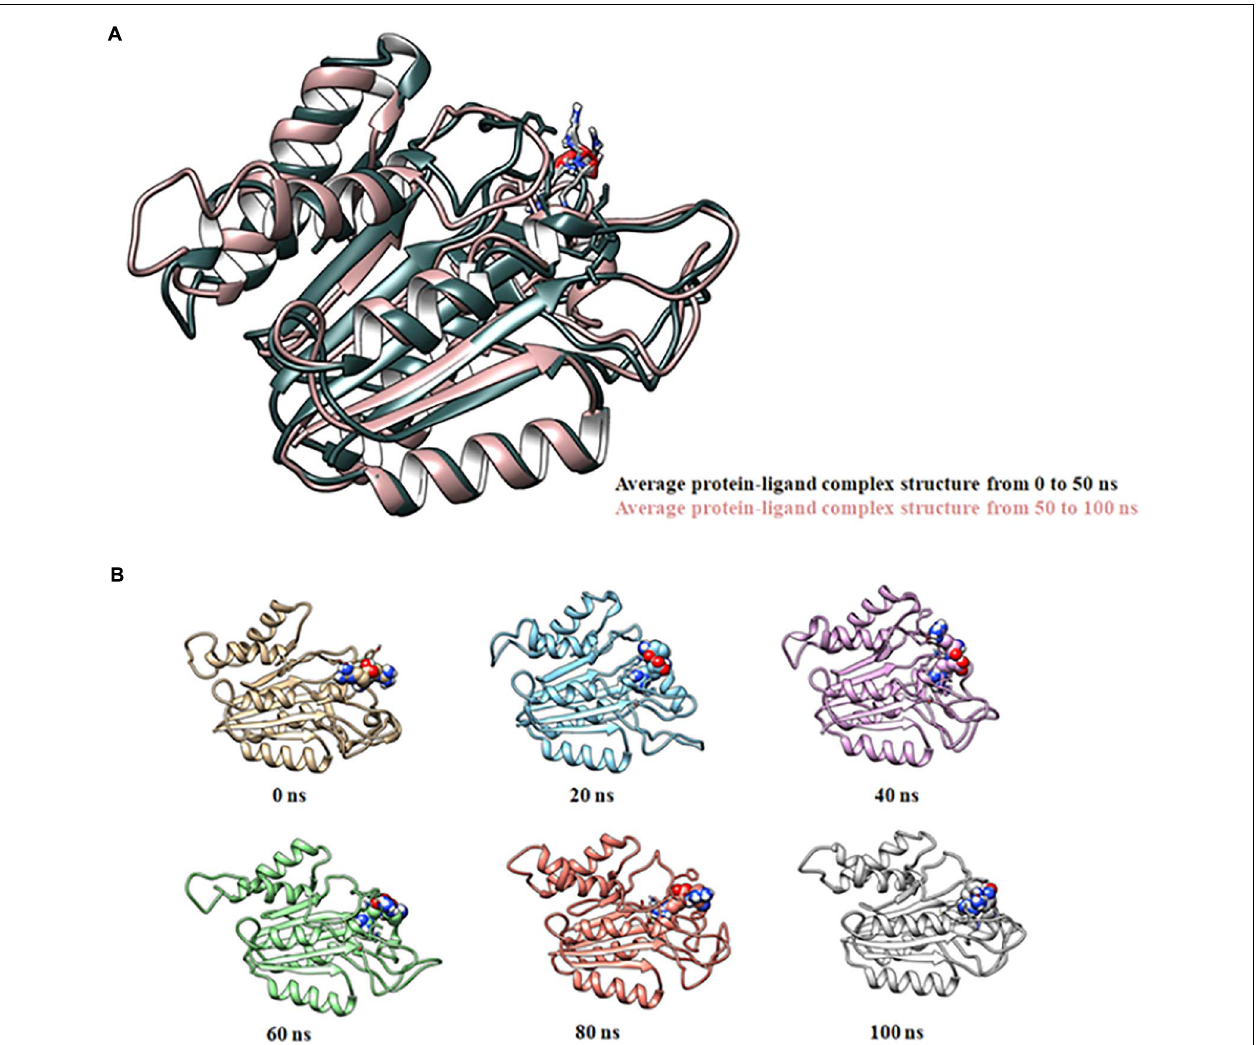
FIGURE 8 | Molecular dynamic simulation of the HC–RR complex for 100 ns displaying its stability. (A) Superimposition of average complex structures between 0 and 50 ns and between 51 and 100 ns for determining the RMSD. RMSD was found to be 0.89 Å, suggesting minor deviation. (B) Snapshot of the HC-RR complex at 0, 20, 40, 60, 80, and 100 ns displaying stable incorporation of RR in the HC throughout the simulation time